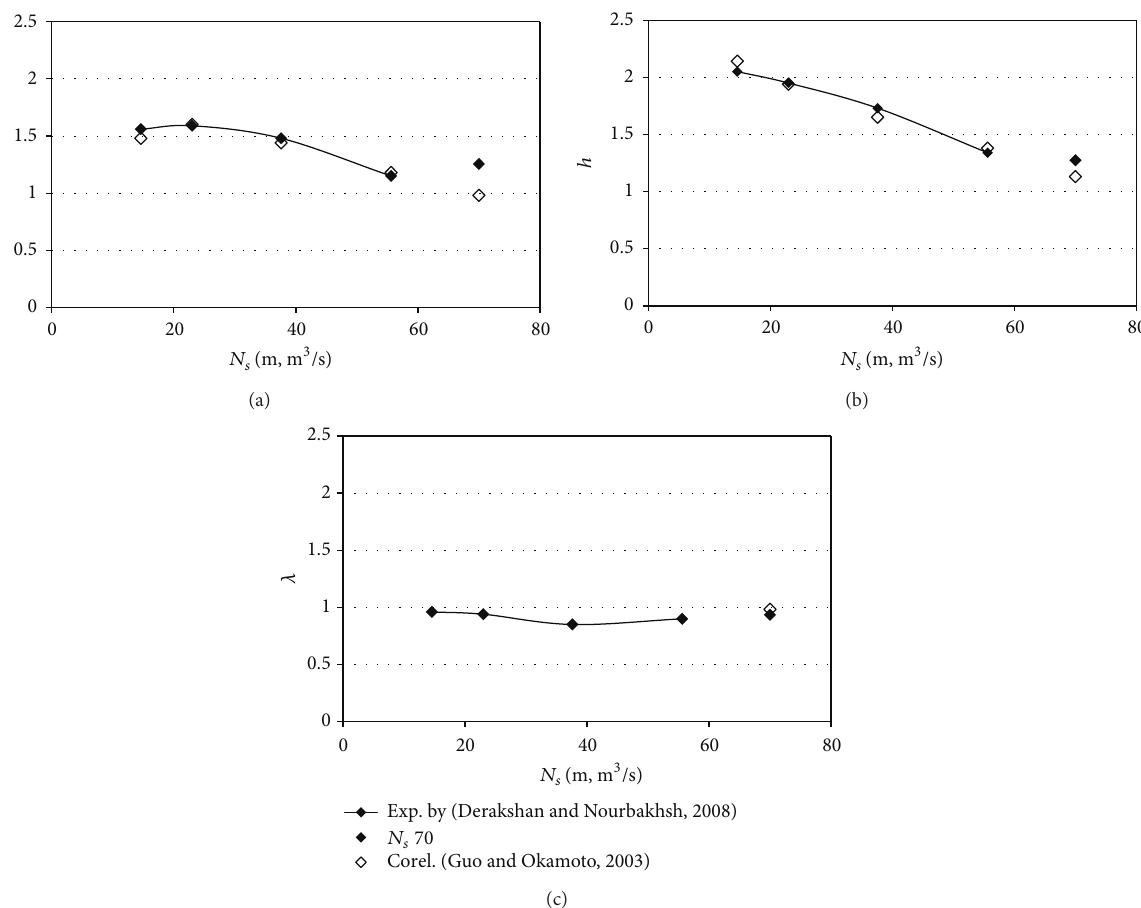
Xeon processors (3.16 GHz), RAM 16 Gb, Windows XP. The average number of processors is equal to